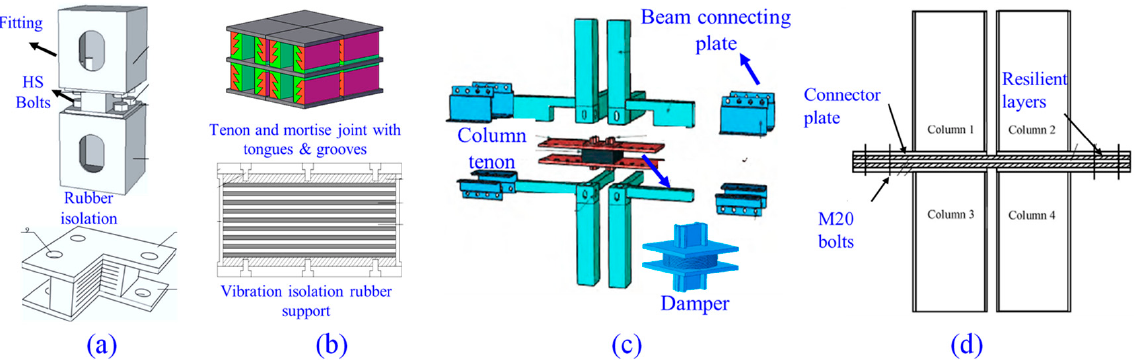
Figure 5. Damping IMC. ( a ) rubber isolator [91]; ( b ) vibration isolation rubber [92]; ( c ) viscoelastic damper [94]; and ( d ) resilient layer rubber [93].